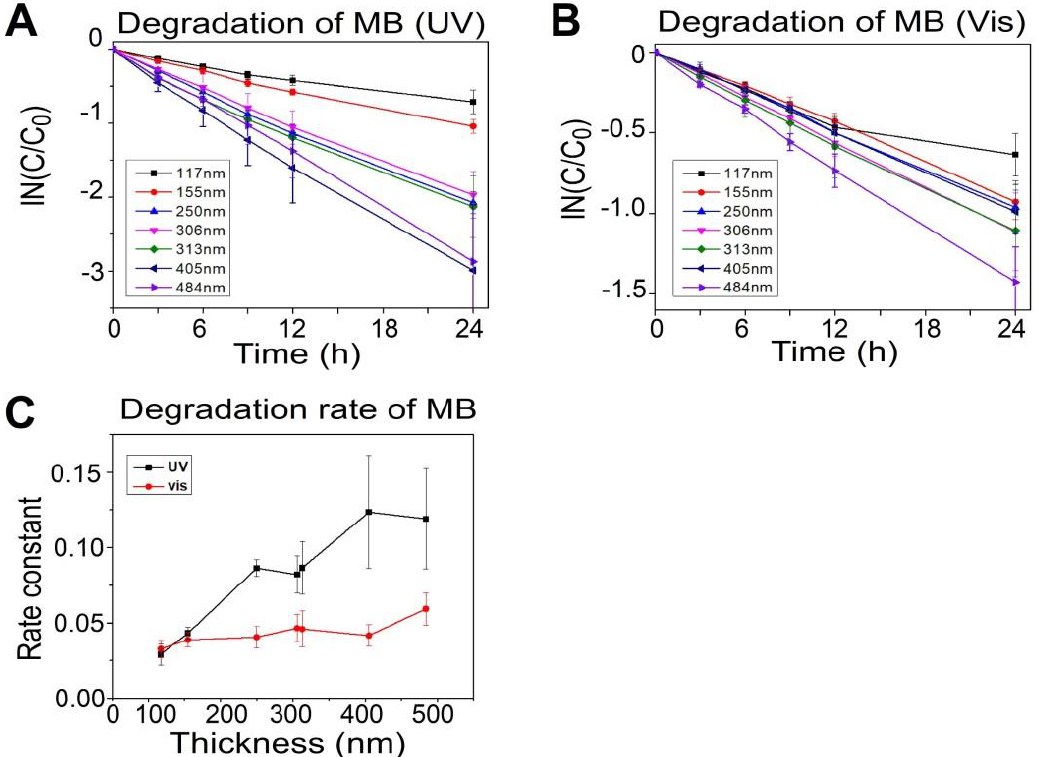
Figure 4. Methylene blue (MB) degradation analyses. The MB degradation of various TiO 2 (B) films, ranging from 117 nm to 484 nm, under UV light ( A ), MB degradation of various TiO 2 (B) films under visible light ( B ), and the degradation rate constant ( C ).